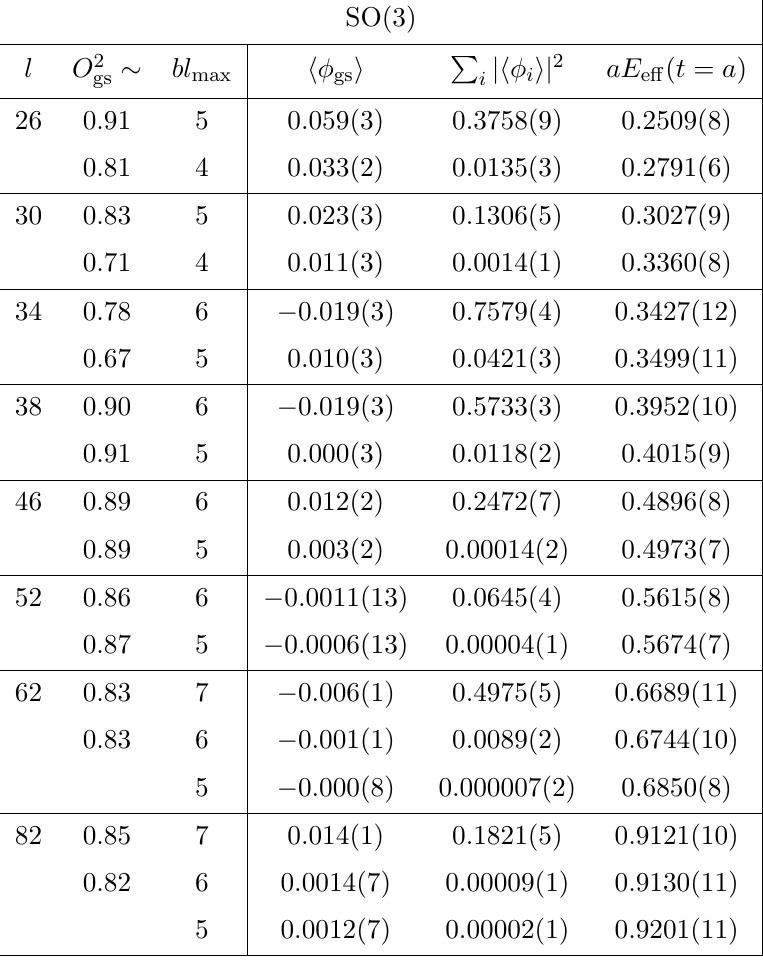
Table 9 . Various overlaps versus length, as described in section 4.2, in SO(3) at (cid:12) = 9 :